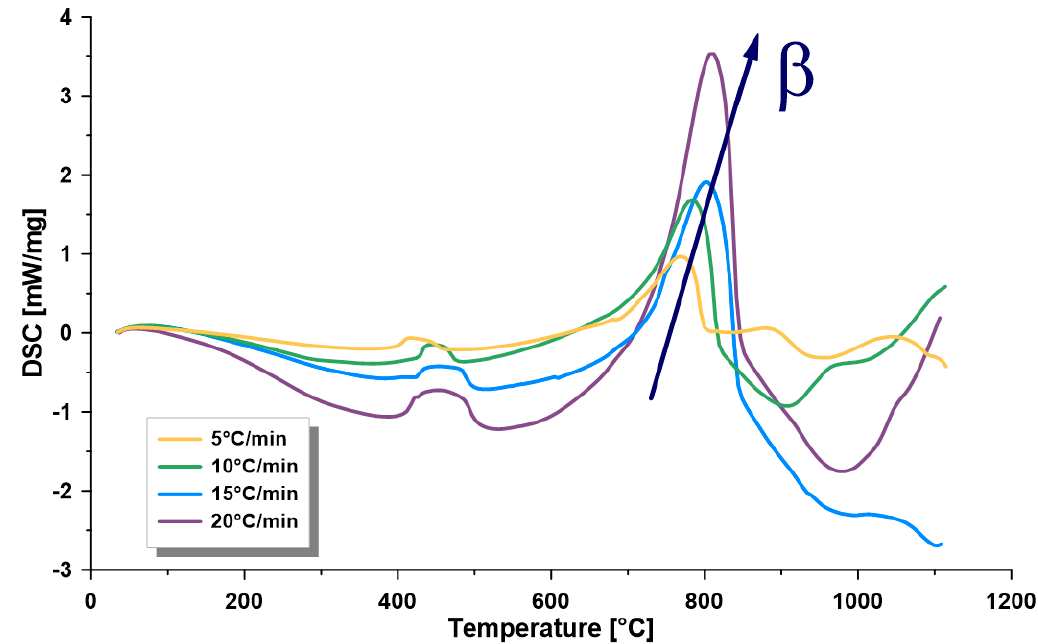
Figure 3. Representative differential scanning calorimetry (DSC) curve at four heating rates ( β ) of 5, 10, 15 and 20 °C/min. Energies 2020 , 13 , 4060